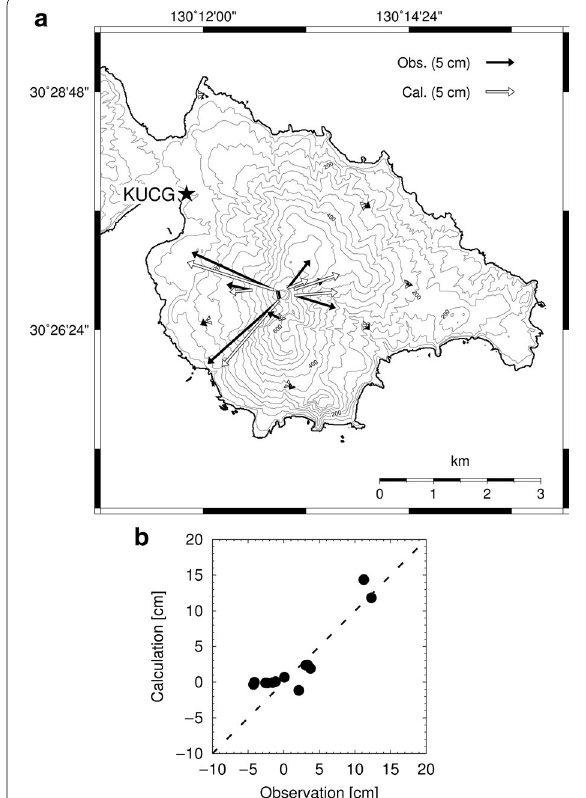
Fig. 9 a Same as Fig. 6a for the result of Mogi-type model. b Same as Fig. 6b for the result of Mogi-type model